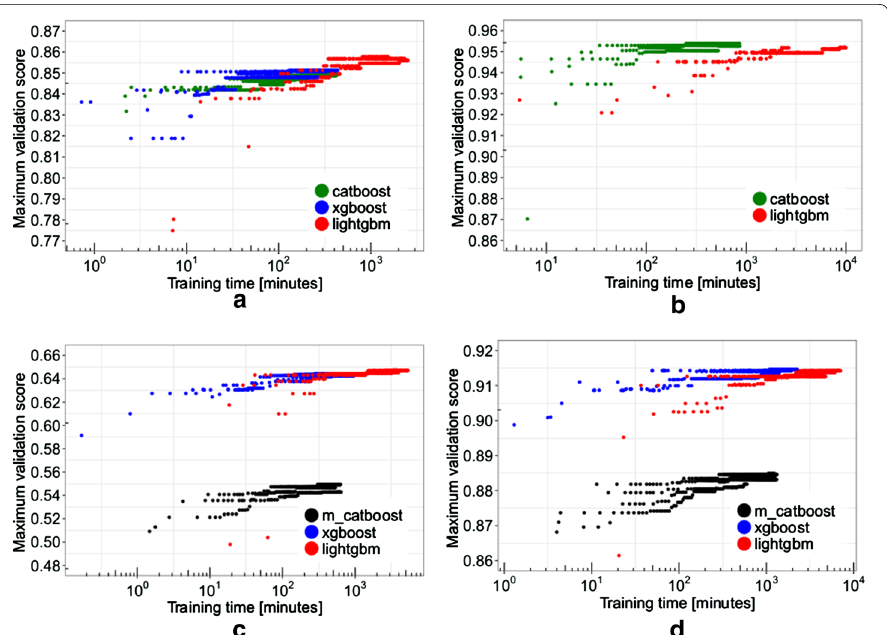
Fig. 1 Image from [8] showing sensitivity of CatBoost to hyper-parameter settings; a records performance on the Higgs benchmark, b performance on the Epsilon benchmark, c performance on the Microsft benchmark, and d performance on the Yahoo